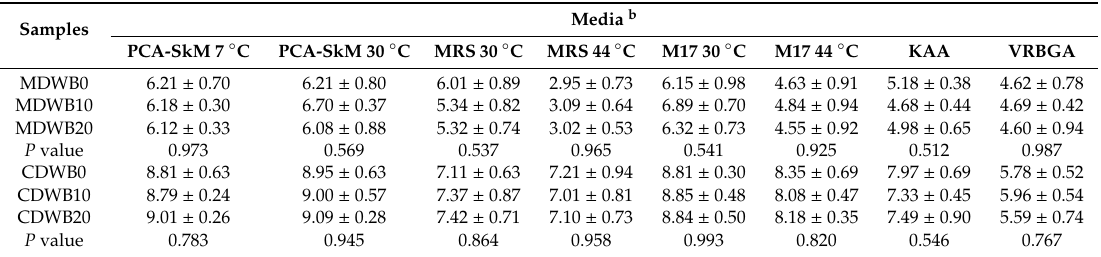
Table 7. E ff ect of feeding regime on microbial loads a of milk and cheese samples.